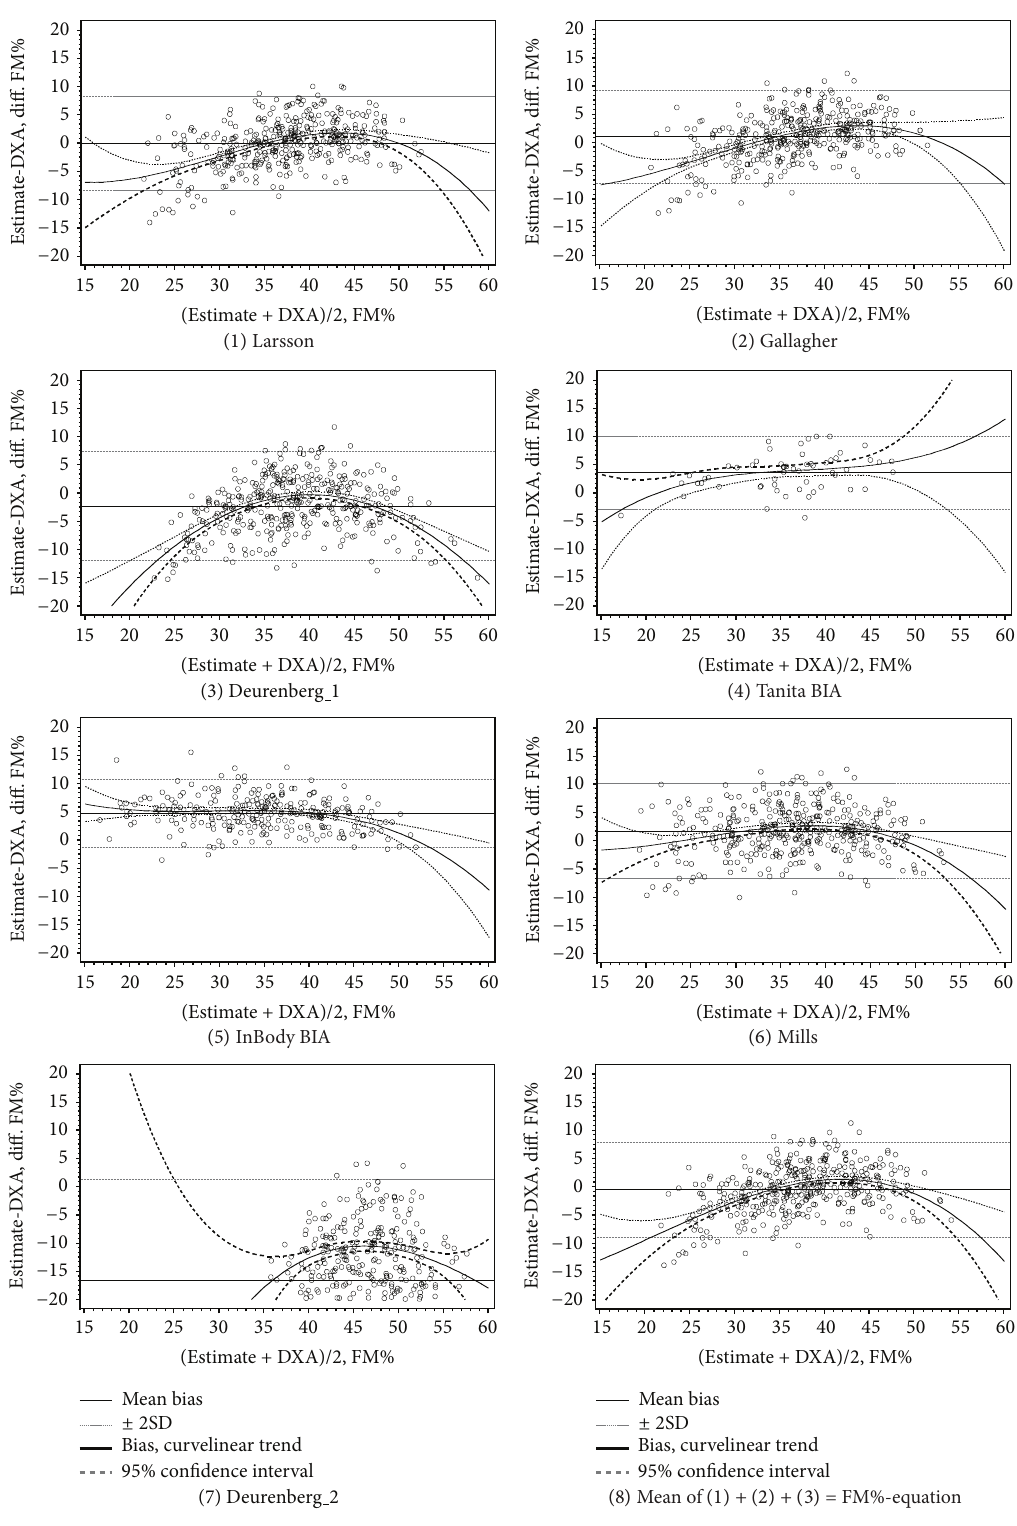
Figure 2: Bland-Altman plots for estimates of fat mass percent (FM%): DXA versus FM%-prediction equations and bioimpedance in